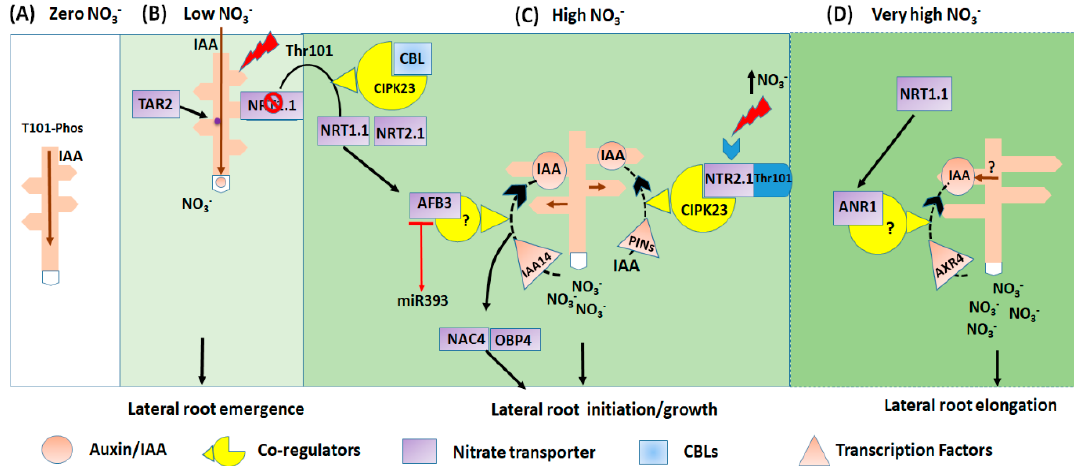
Figure 1. NO 3 − regulates auxin activity, and consequently controls the NO 3 − assimilation pathway and transport. The model represents the root morphology subjected to four di ff erent nitrate conditions. ( A ) The deficient (zero) NO 3 − stimulates auxin translocation from shoot to roots. ( B ) This mechanism is utilized under low NO 3 − conditions, either NRT1.1 transport auxin from shoot to root, causing LRs emergence, or reduced the auxin storage in primordia and new lateral root tip, and subsequently inhibits LRs emergence and elongation. Thus considered as the principal regulator for the auxin biosynthesis in the root promotes lateral root growth. ( C ) Under the high nitrate NO 3 − condition; NRT1.1 induces the expression of AFB3 , and the AFB3-dependent auxin signalling, regulates root growth. The AFB3-NAC4-OBP4 signalling network expressed their protein in the root pericycle of the cell. The NAC4 and OBP4 part of the pathway is probably regulated by AUX / IAA protein IAA14. The black dotted arrow indicates the e ff ect of AFB3 on the IAA accumulation, promotes lateral root initiation under high nitrate condition. ( D ) Under the excessive supply of NO 3 − ; NRT1.1 stimulates the ANR1-dependent signalling pathways that modulate lateral root elongation. The black dotted arrow indicates the e ff ect of NRT1.1 on the IAA accumulation and expression of ANR1 in the LRs primordial, and lateral root development. The question mark represents the unconfirmed e ff ect of NRT1.1 nitrate transport activity on the expression of ANR1